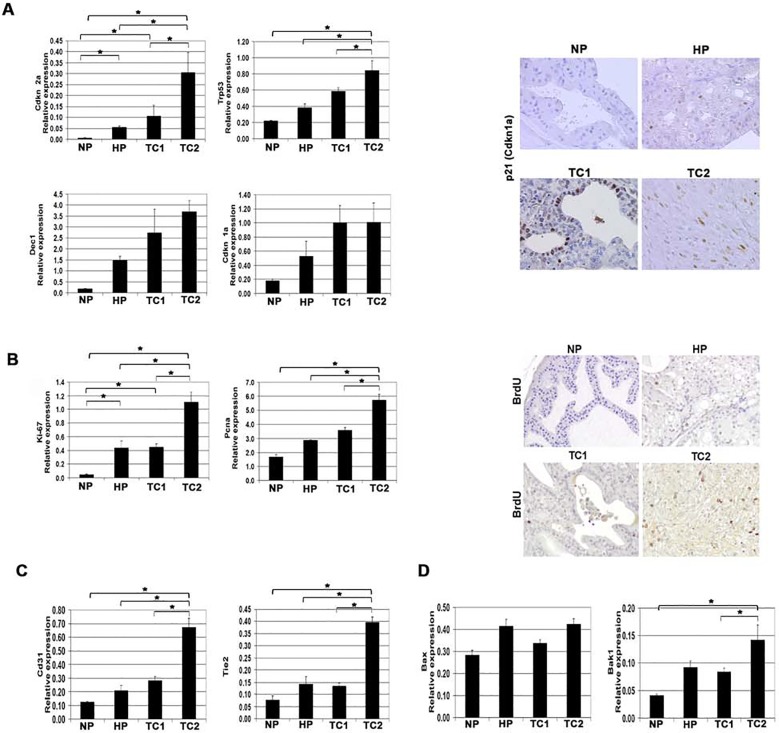
Differential expression of markers associated with senescence, proliferation, angiogenesis and apoptosis in TC1 and TC2 prostate tumors as compared to HP/NP in targeted Pten knockout mice.(A) Relative mRNA expression levels of senescence markers Cdkn1a, Trp53, Cdkna2a and Dec1 in NP, HP, TC1 and TC2 (left panel). Representative p21 immunostaining in tissue slides of the anterior prostate lobe of NP, HP, TC1 and TC2 (right panel). Magnification: 200x. (B) Relative mRNA expression levels of proliferation markers Ki67 and Pcna and representative pictures of BrdU+ cells in anterior prostate lobes of NP, HP, TC1 and TC2 (Magnification: 200x). (C) Relative mRNA expression of angiogenesis markers CD31 and Tie2 in NP, HP, TC1 and TC2. (D) Relative mRNA expression of pro-apoptotic markers Bax and Bak1 in NP, HP, TC1 and TC2. The indicated gene expressions were plotted relative to the housekeeping gene Hprt. Sample size NP, HP and TC1 (n = 3) and TC2 (n = 6). Data are given as mean +/- SE. * p < 0.05 by Mann-Whitney two tailed test.